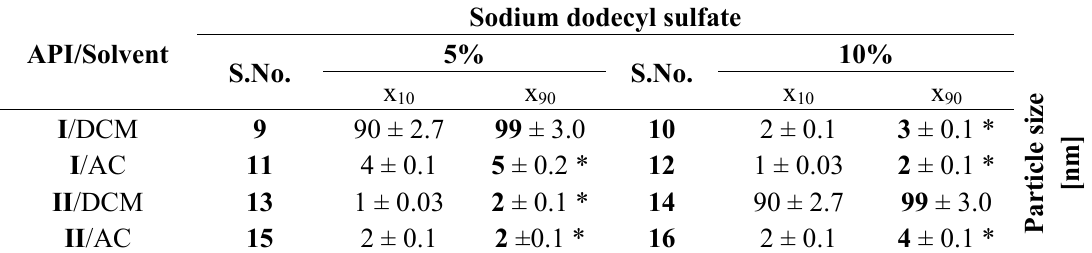
Table 2. Particle size (x , x [nm]) of APIs I , II and concentration [%] of sodium dodecyl 10 90 sulfate in dichloromethane (DCM) or acetone (AC). All the presented results are reported as the medium value of four independent measurements. The results of nano-size samples are expressed as the mean ± SD ( n = 4 measurements). The SDs of micro-size samples are not indicated due to the measurability range of Nanophox. Samples that contained nanoparticles <200 nm are bolded; nanoparticles <10 nm are indicated by asterisk. (S.No. = sample number).